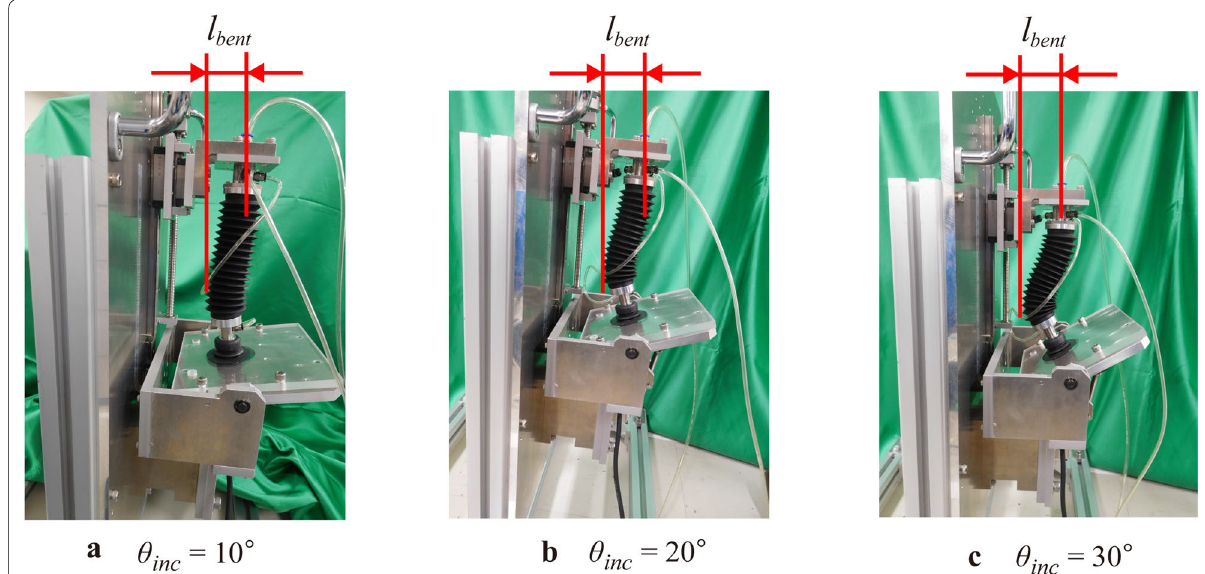
Fig. 17 Experimental view of tolerance evaluation for tilting. a θ inc